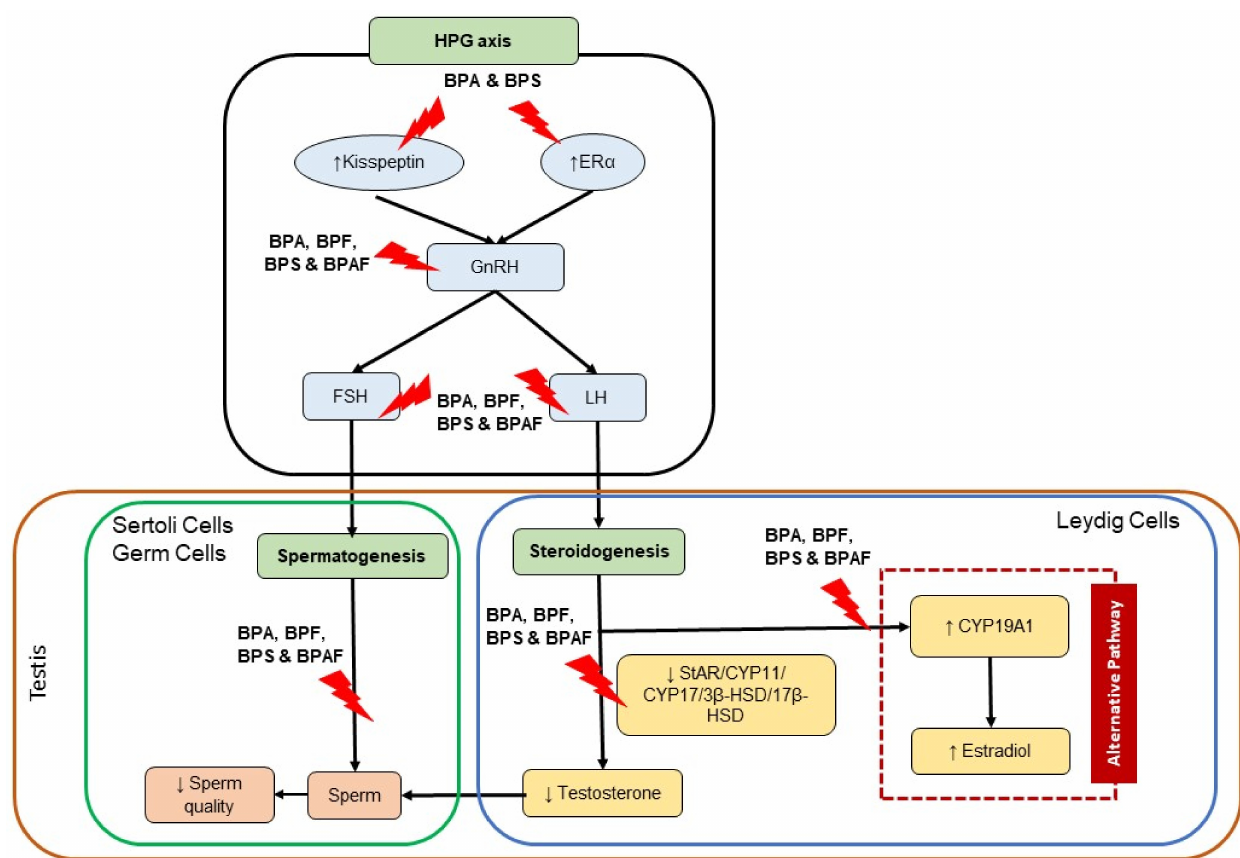
Figure 1. Possible mechanism of BPA and its analogues on the hormonal physiology of male reproductive system. Abbreviations: ↓ inhibit/decrease, ↑